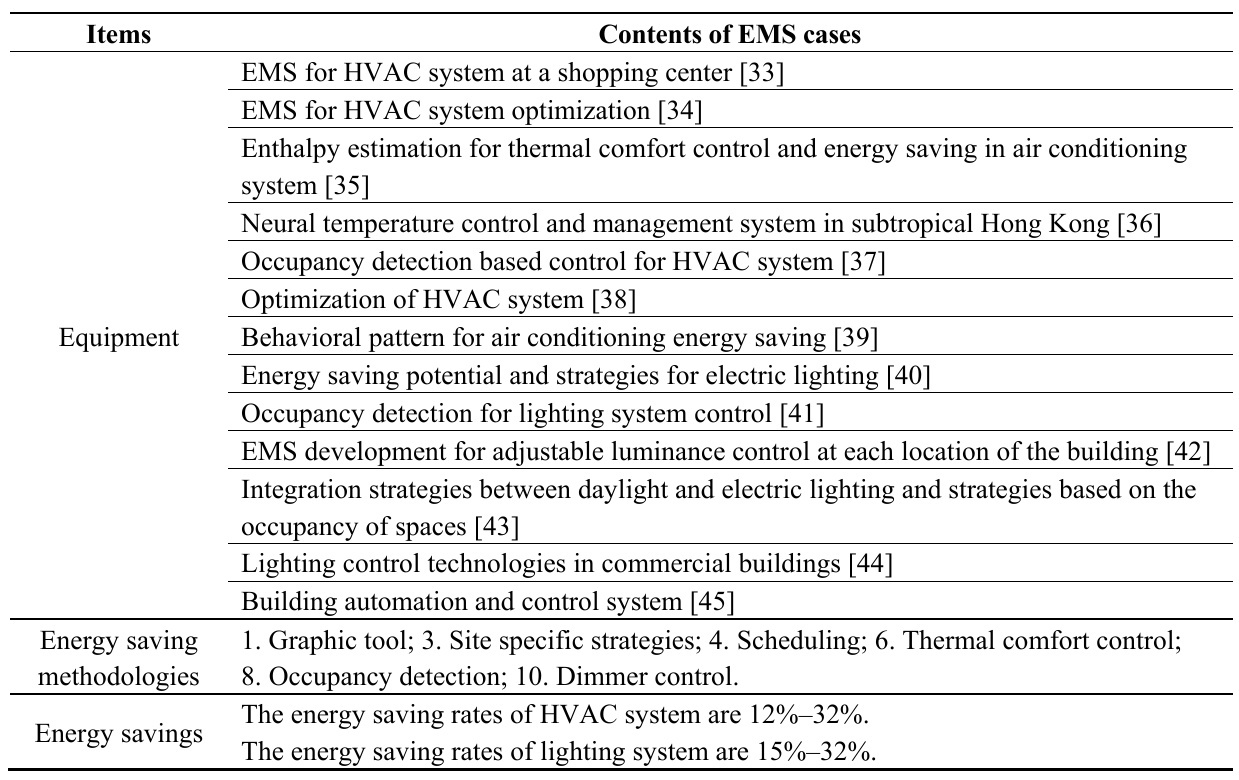
Table 3. The selected EMS cases of single